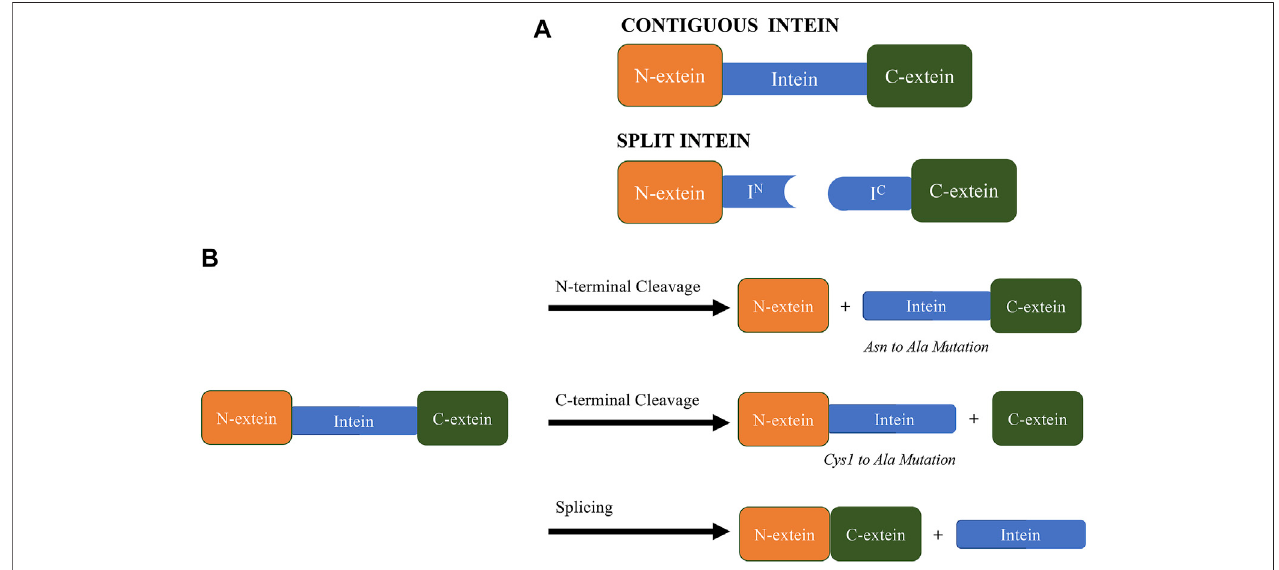
FIGURE1 | (A) . The drawing ofsplit and contiguous inteins. (B) . Examplesofproducts obtained from different intein splicing and cleaving reactions. Itisimportant tonotethatmutationofthelastasparagineandthe fi rstcysteine(orSer1)toalaninerendermostinteinsN-andC-terminalcleaving.Othercriticalresidueswithincatalytic center affecting activity of inteins, including His429/His125, His73/His72, Thr70/69 and Asp422/Asp118 from Mycobacterium tuberculosis RecA (PDB ID 2IMZ) and Nostocpunctiforme (PDBID2KEQ),respectively(VanRoeyetal.,2007;Oeemigetal.,2009;Frutosetal.,2010;Ramirezetal.,2013;Eryilmazetal.,2014;Wood& Camarero, 2014; Cronin et al.,